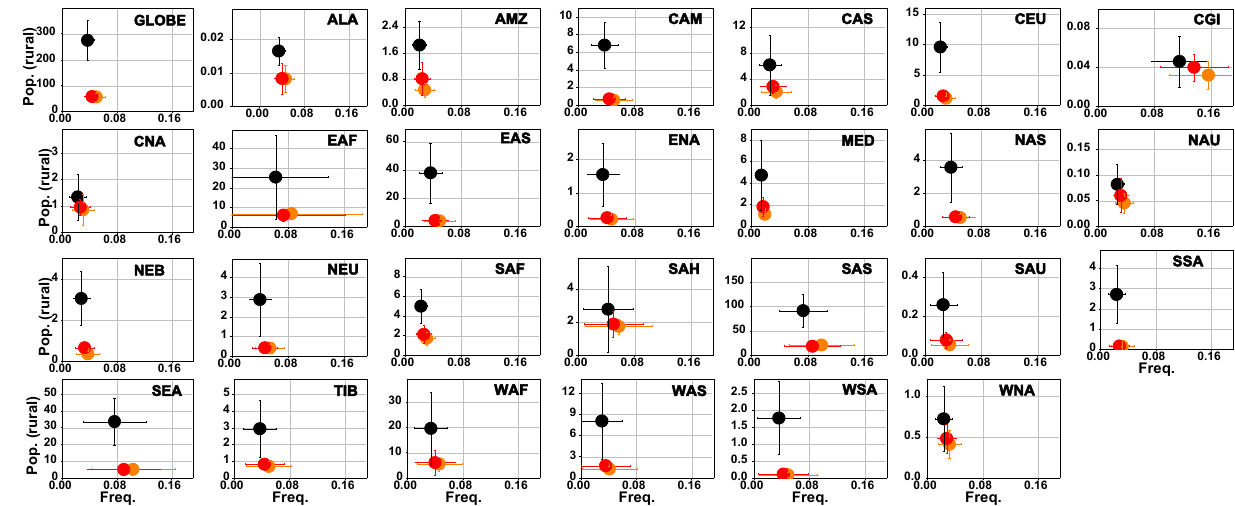
Figure 13. Multi-model projected frequency (Freq.) and affected rural population (Pop., in millions) by severe drought (PDSI < − 3) globally and in 27 regions for the baseline period (black, fixed SSP1 2000 population) and the 1.5 ◦ C (orange, fixed SSP1 2100 population) and 2 ◦ C (red, fixed SSP1 2100 population) warmer worlds. The projected uncertainties (standard deviation of multiple-model results) of multiple climate models are shown by error bars (horizontal and